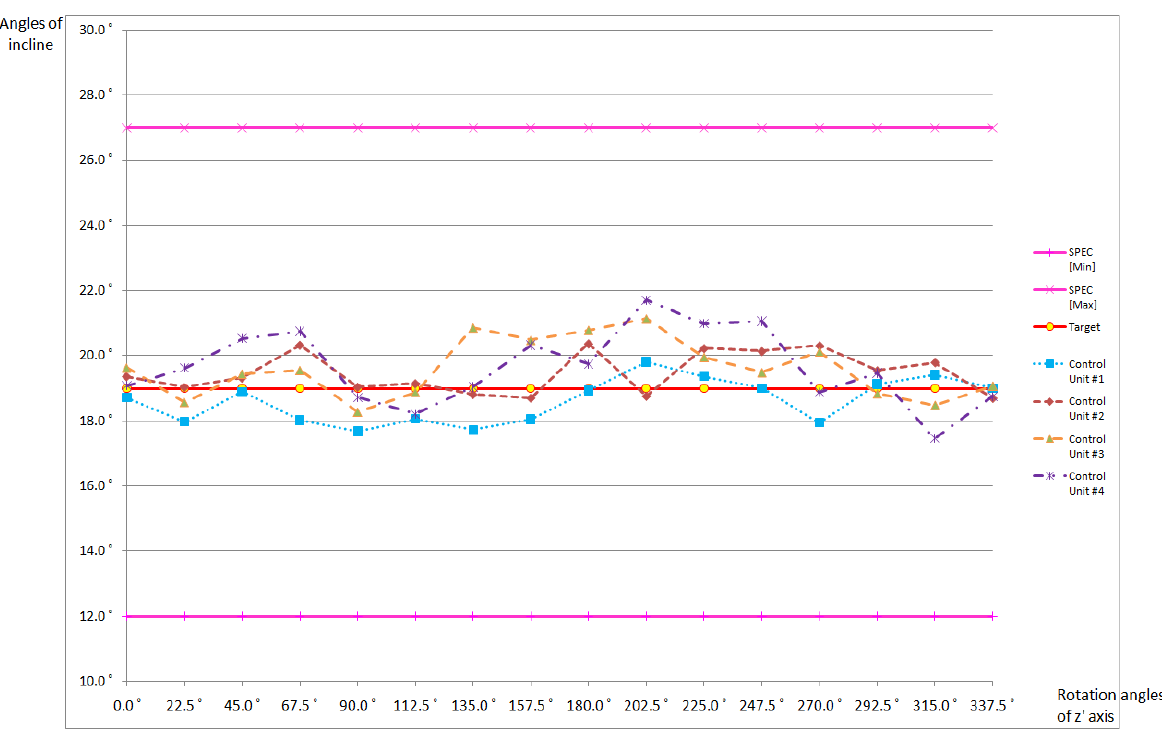
Figure 11. Experiment result of overall control